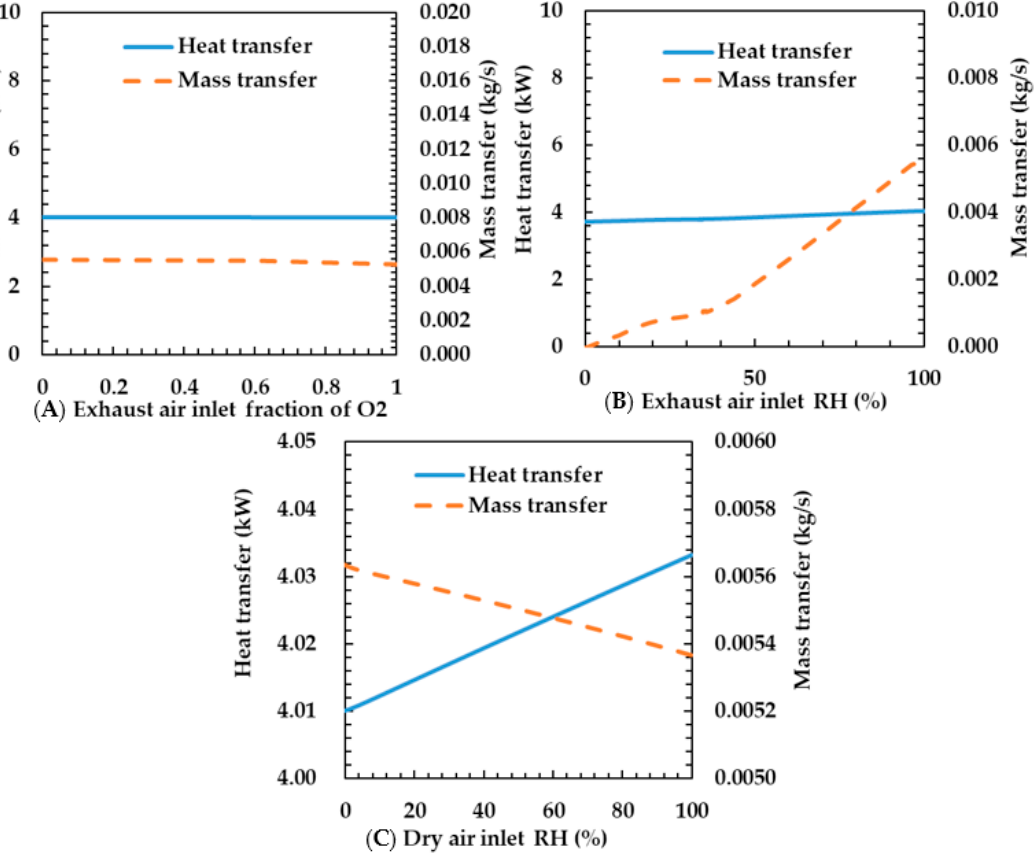
Figure 9. Effects of exhaust air inlet fraction of oxygen ( A ), exhaust air inlet RH ( B ), and dry air inlet RH ( C ) on heat and mass transfer rates of the porous metal foam humidifier.